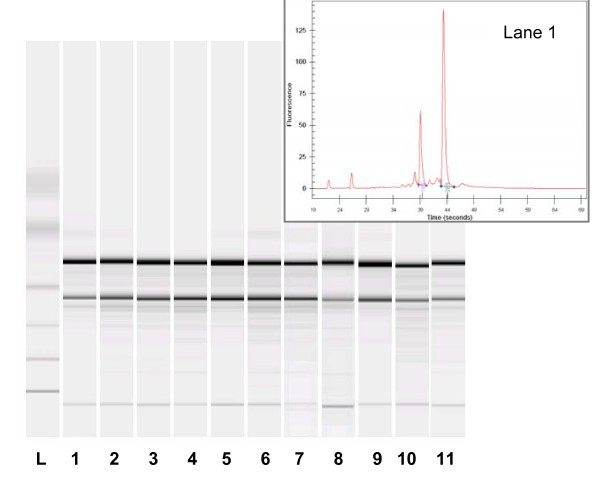
Total RNA samples run on an Agilent 2100 Bioanalyzer RNA 6000 Nano LabChip. L, Ladder/marker; 1–2, pre-veraison pericarp; 3, veraison pericarp; 4, post-veraison pericarp; 5–6, pre-veraison seed; 7, veraison seed; 8, post-veraison seed; 9, root; 10, pre-anthesis flower; 11, post-anthesis flower. The fluorescence plot shown in the upper right corner is an example of the electropherogram with 18S and 28S peaks.